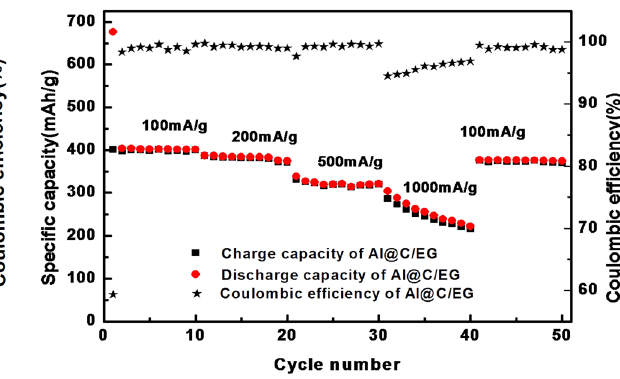
Figure 9: The cycling performance and coulombic e ffi ciencies of C@Al – EG composites